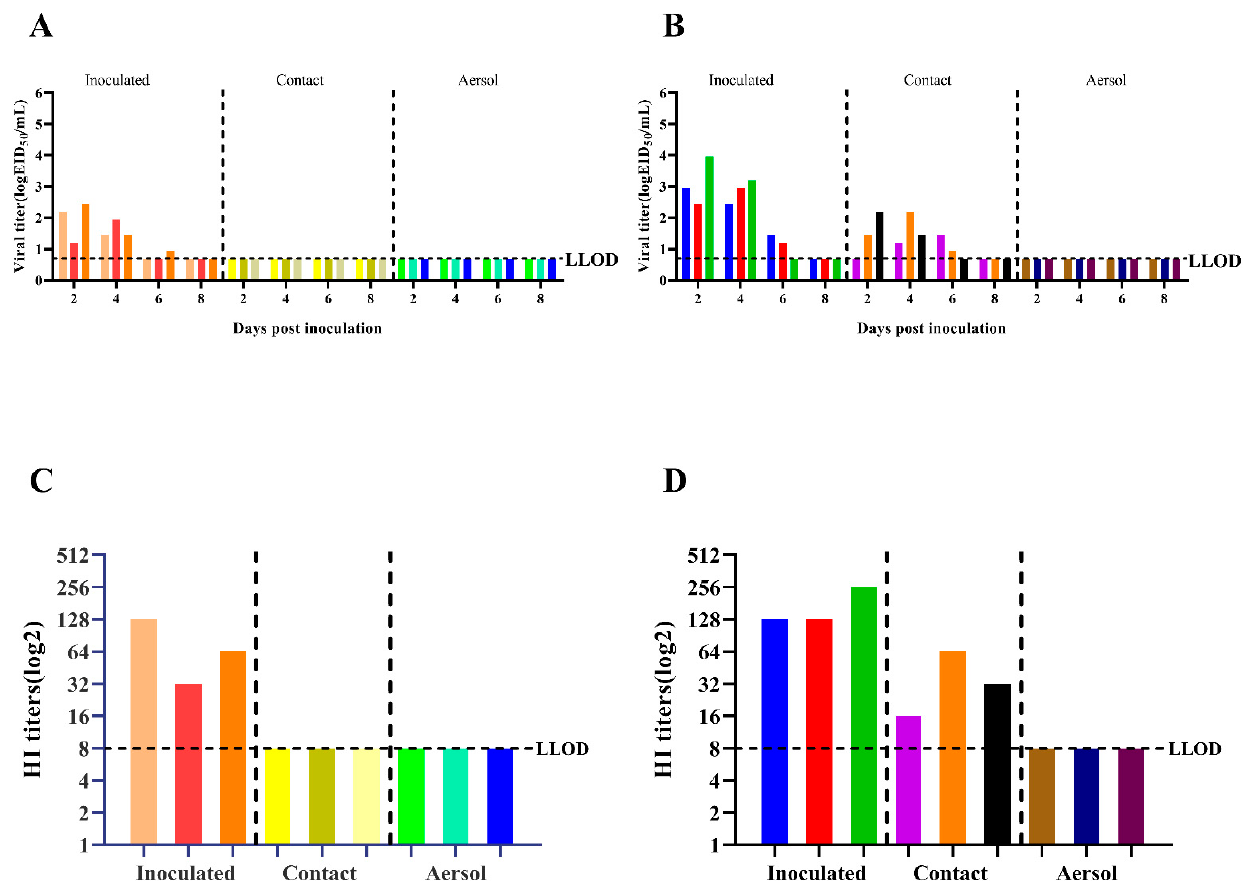
Figure 5. Transmission of H5N6 (CK05 and GD07) viruses in guinea pigs. ( A ) X -axis: guinea pigs in the groups infected with CK05, exposed to direct contact, and transmitted by aerosols. Y -axis: influenza virus titers in guinea pig nasal washes. ( B ) X -axis: guinea pigs in the groups infected with GD07, exposed to direct contact, and transmitted by aerosols. Y -axis: influenza virus titers in guinea pig nasal washes. ( C ) X -axis: guinea pigs in the CK05 infection group, direct contact group, and aerosol transmission group. Y -axis: HI antibody titers of different guinea pigs. ( D ) X -axis: guinea pigs infected with GD07 group, directly exposed group and aerosol transmitted group. Y -axis: HI antibody titers of different guinea pigs. Each color bar represents an individual guinea pig. LLOD is indicated with a black dotted line.